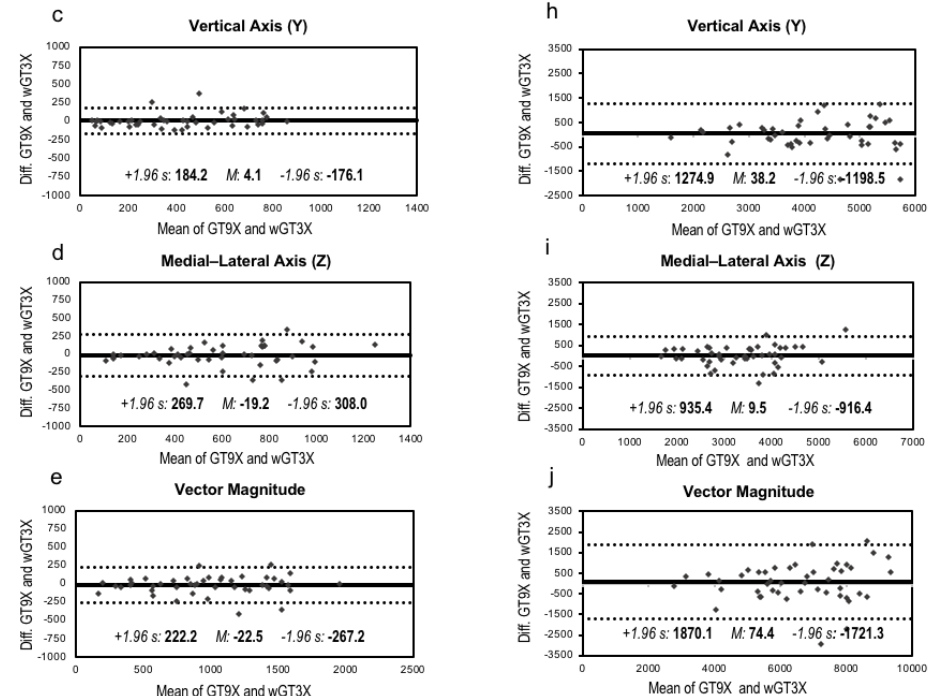
Figure 1. Bland-Altman plots and intraclass correlation (ICC). The solid line represents the mean bias ( M ), whereas the dotted line indicates the limits of agreement computed as the mean bias plus or minus 1.96 times its standard deviation (s). ICC represents intraclass correlation that measures the agreement of measurements between the GT9X and wGT3X. Data in Figure ( a – e ) are from the hip-worn monitors, whereas data in Figure ( f – j ) are from the wrist-worn monitors. J. Clin. Med. 2018 , 7 , x FOR PEER REVIEW